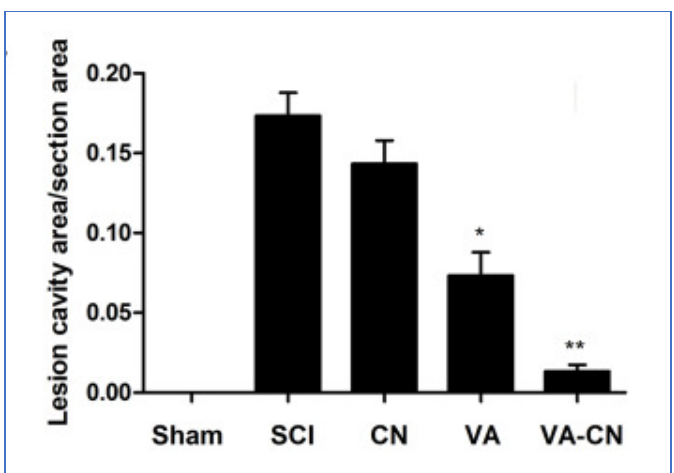
Figure 3. The lesion cavity was quantified in the injured spinal cords, i.e., n = 10 for the sham group, n = 12 per experimental group. * p < 0.05, ** p < 0.01 versus SCI group. Adapted with permission [84].